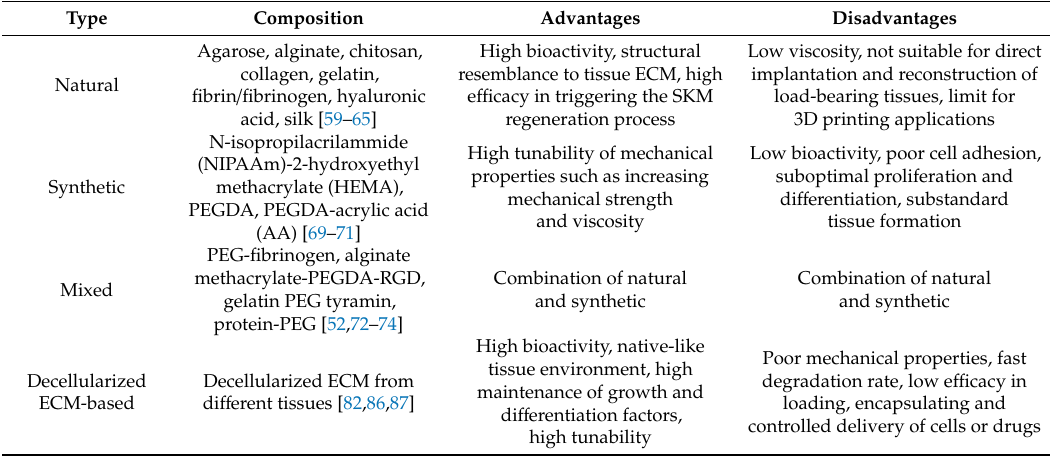
Table 2. Di ff erent types of hydrogels utilized for skeletal muscle (SKM) tissue engineering approaches. Corresponding references are cited for each type of hydrogel. Advantages and disadvantages are summarized for each